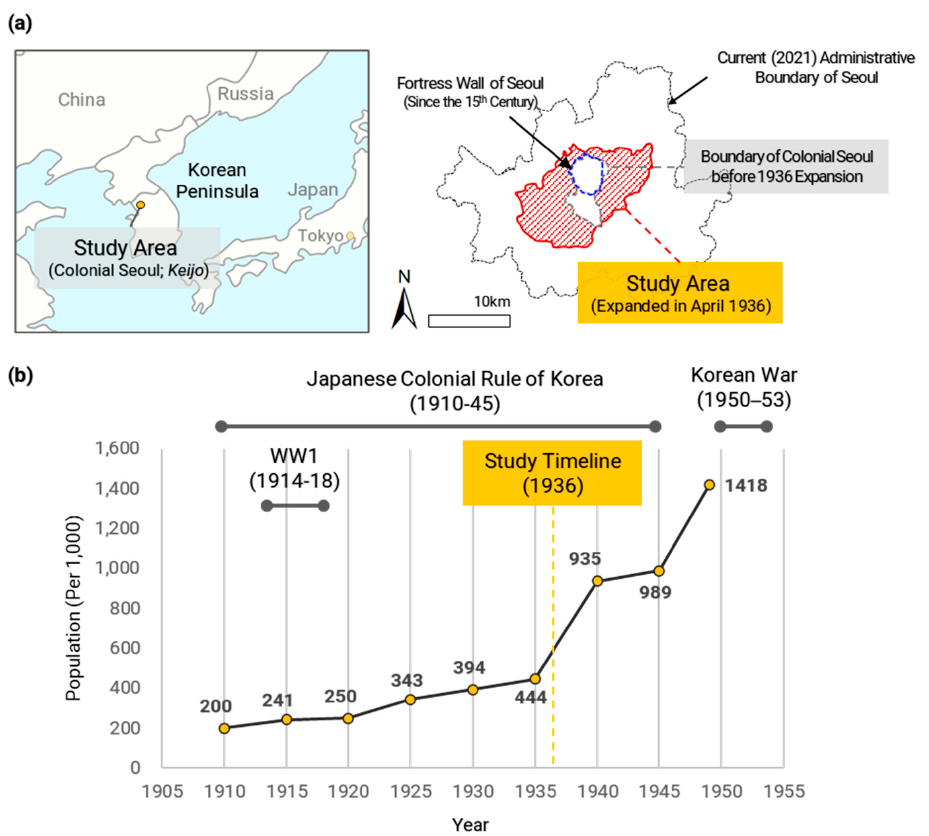
Figure 1. ( a ) Study area (colonial Seoul, the capital of Korea under the Japanese empire) and ( b ) study timeline (1936).